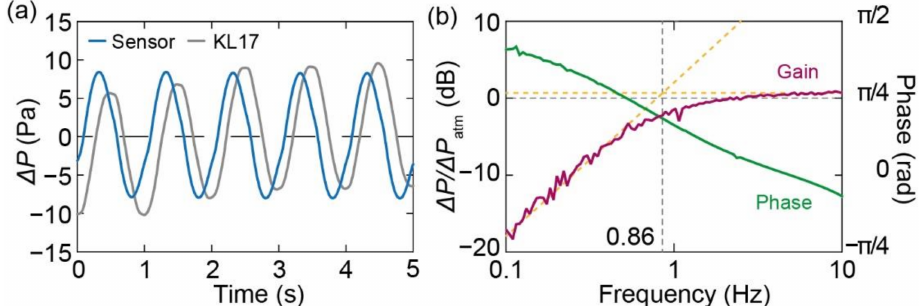
Figure 7. ( a ) Output waveform for applied frequency of 1 Hz. ( b ) Frequency response of sensor unit.